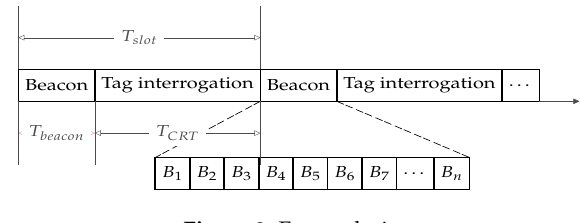
Figure 3. Frame design.